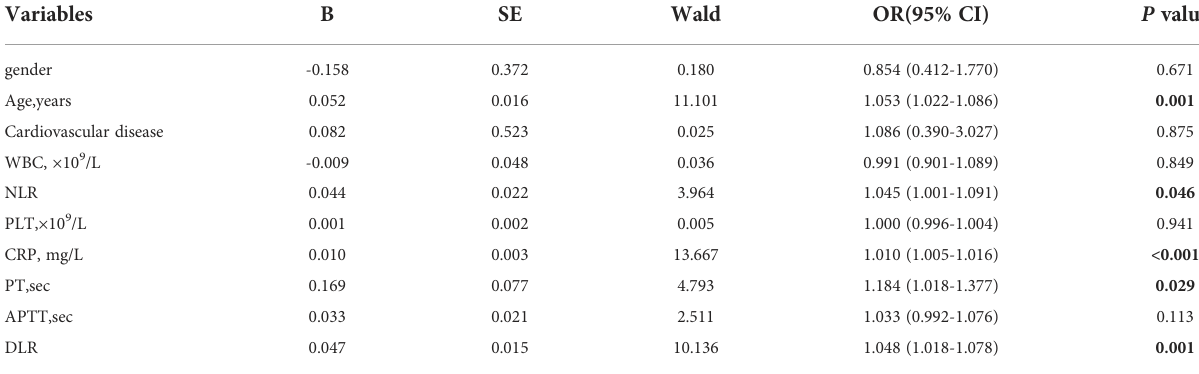
TABLE 4 Multivariate analysis of risk factors related to the mortality of COVID-19 patients.